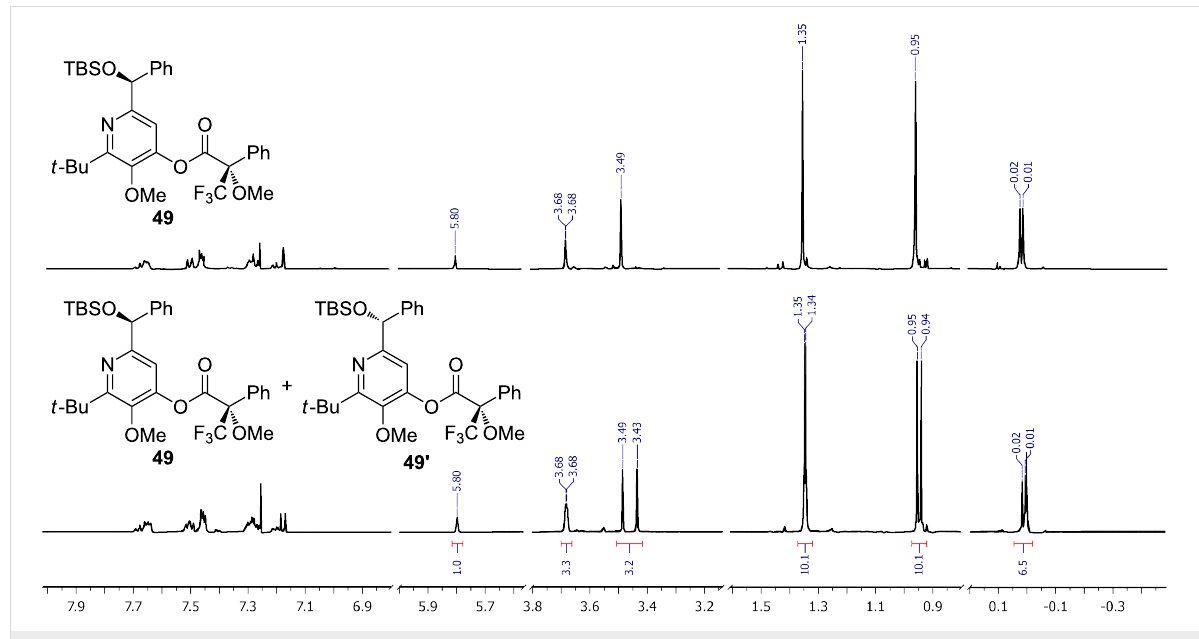
Figure 1: 1 H NMR spectra of 49 and the mixture of diastereoisomers 49 and 49’ .